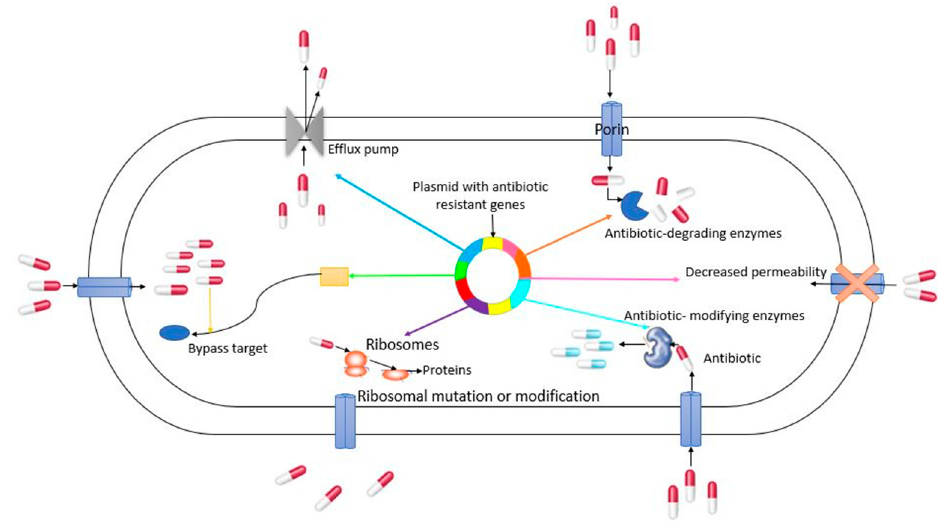
Figure 1. General mechanisms of antimicrobial resistance (Elaborated from references [10] and [11]).